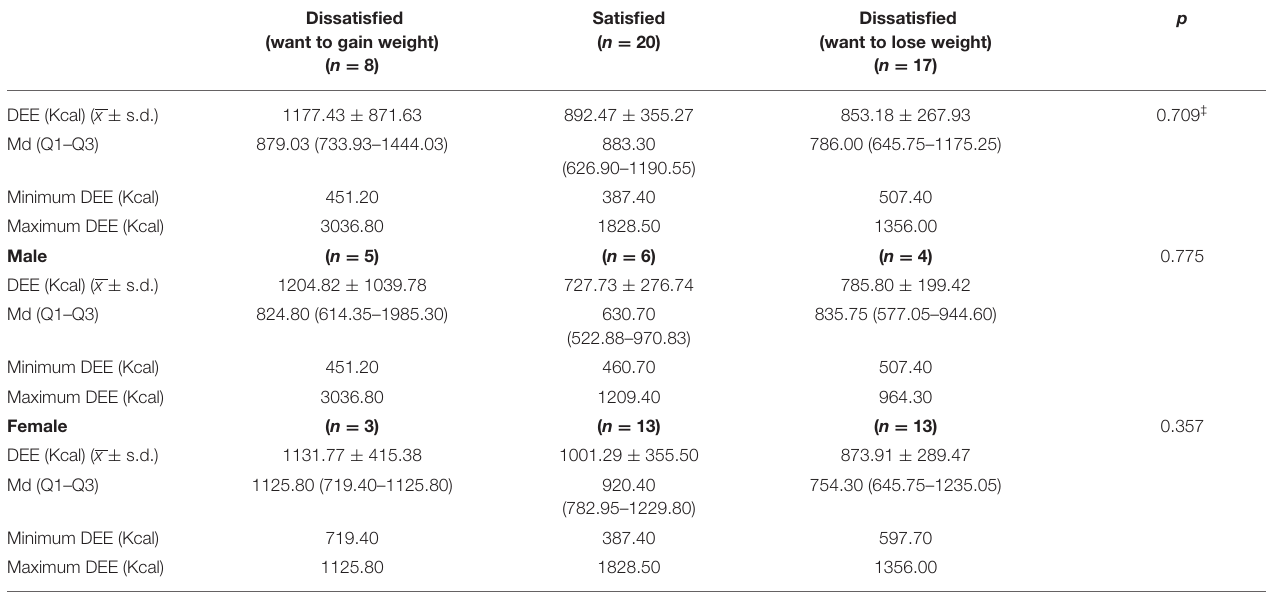
TABLE 5 | Descriptive statistics of daily energy expenditure of all the activities described in the Quantification de l’Activite Physique en Altitude Chez les Enfants